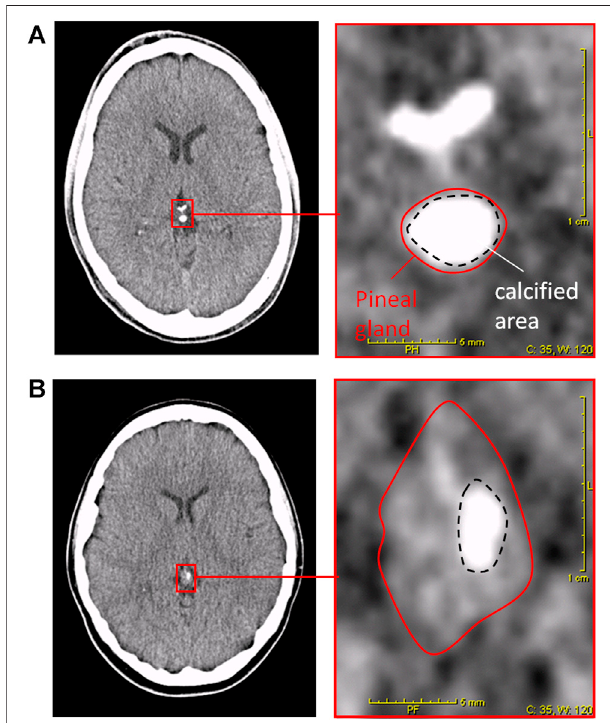
FIGURE 1 | Degree of pineal calci fi cation (DOC) in cCT-image analysis (Kunz et al., 1999) . Left pictures depict cCT 2-mm slices including the pineal gland.Rightpicturesdepictmagni fi cationofredframedareaintheleftpicture. Red solid lines surround the total pineal gland. Black dashed lines surround the calci fi ed area of the pineal gland. Patient (A) : HE max (cid:1) 418; calci fi ed portion: 80%; DOC (cid:1) (3 + 3)/7 (cid:1) 0.86. Patient (B) : HE max (cid:1) 164; calci fi ed portion: 14%; DOC (cid:1) (1 + 0)/7 (cid:1) 0.14.